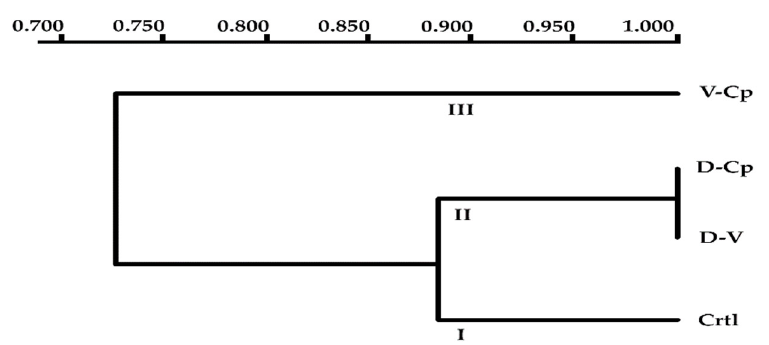
Figure 3. Genetic similarity dendrogram based on Jaccard’s coefficient. Neighbor-joining analysis after six months of greenhouse culture of in vitro controls (Ctrl) and of cryo-derived regenerants produced using three vitrification-based techniques.: D-V: droplet-vitrification, V-Cp: V-cryoplate, D-Cp: D-cryoplate. The values of coefficient of similarity represent: 1 similarity and 0 divergence. Table 4. Analysis of electrophoretic profiles with the ISSR primers (T05, T06, C07, UBC-823, UBC- 836, UBC-840 and UBC-848) to detect polymorphisms in greenhouse-grown V. planifolia in vitro con- trols and in cryo-derived regenerants using three vitrification-based techniques.